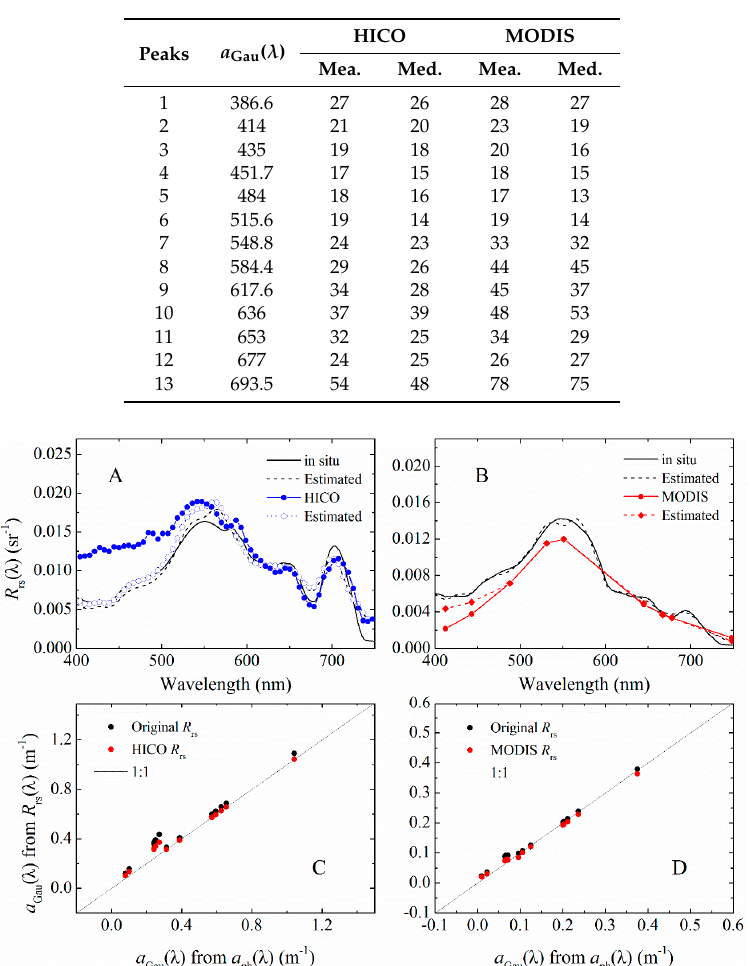
Table 7. The mean (Mea.) and median (Med.) of unbiased absolute percentage differences of a Gau ( λ ) estimated from R rs ( λ ) of HICO and MODIS satellite imagery. HICO Peaks a Gau ( λ )